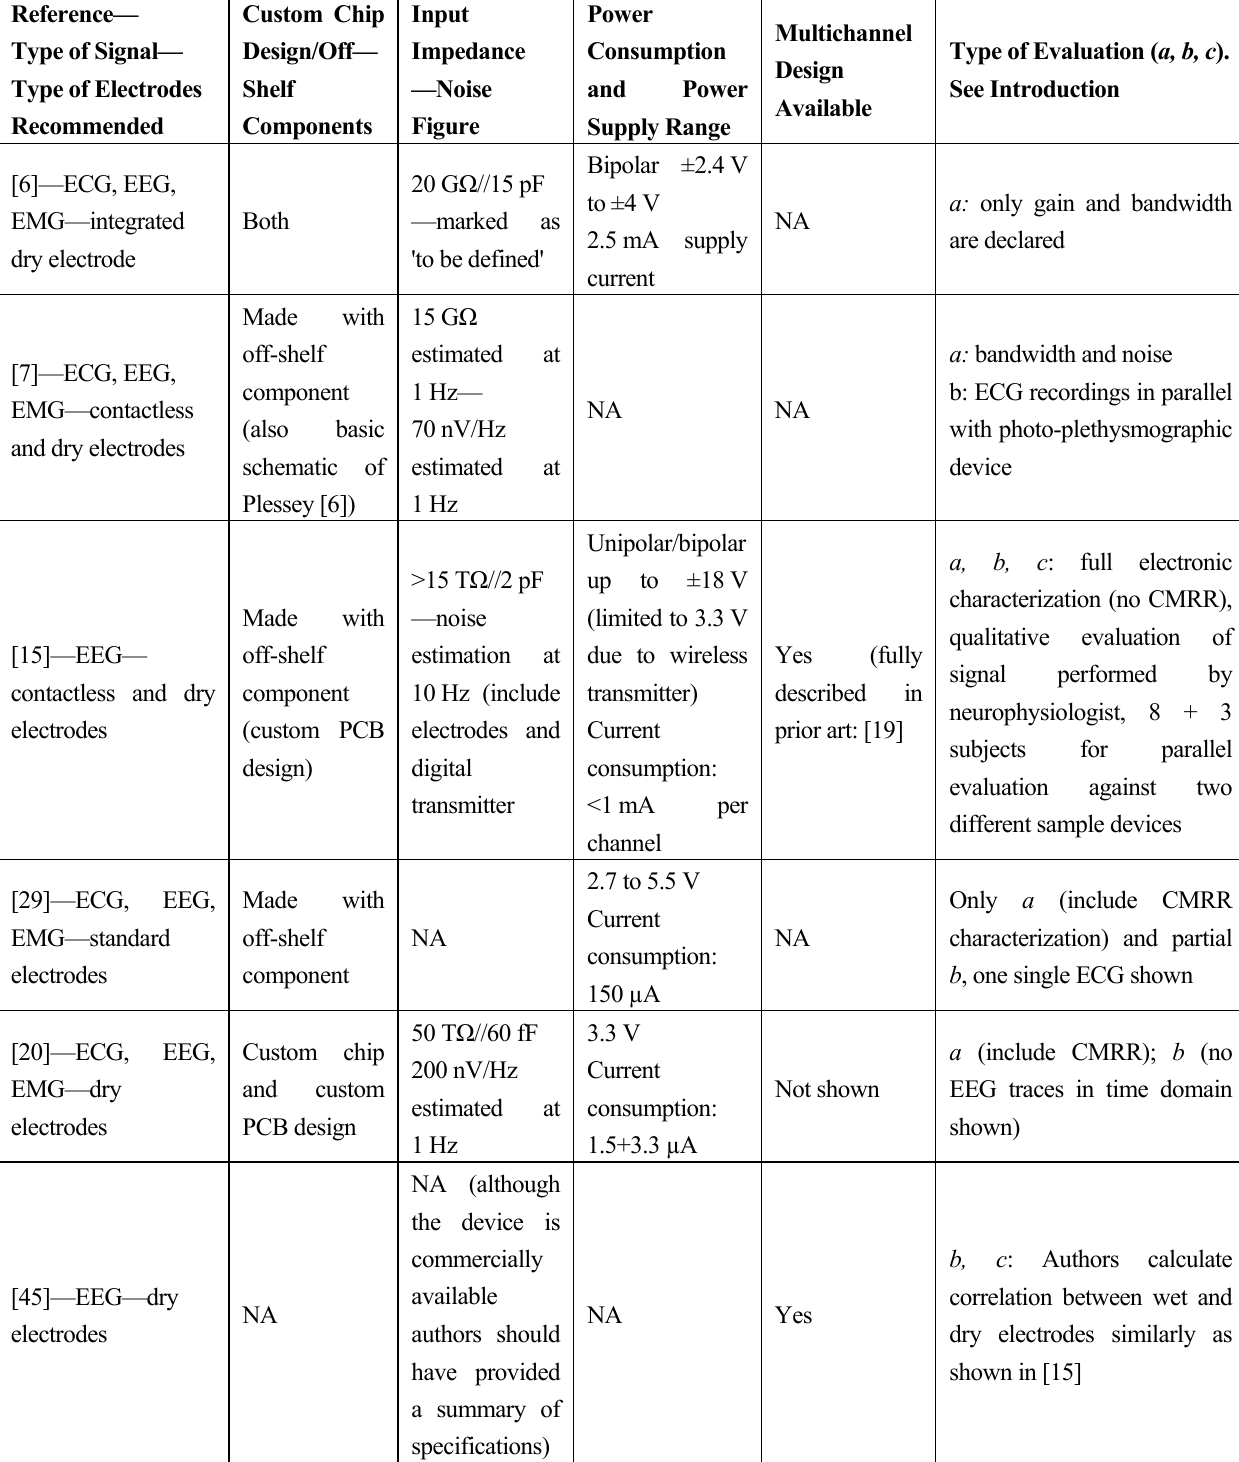
Table 1. Synoptic table of the assessment of biopotential front-ends performed by the reviewed